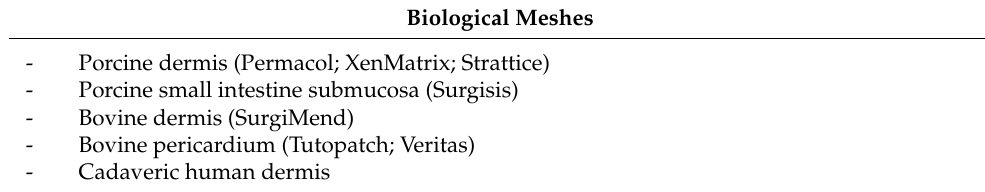
Table 4. Biological meshes for the reconstruction.